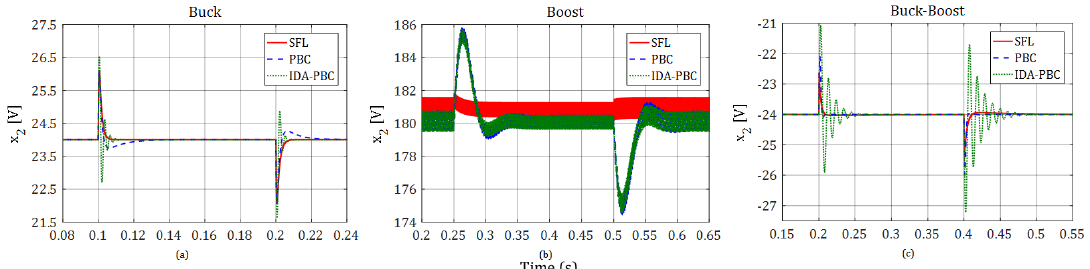
Figure 19. Software simulation result using control techniques SFL (red), PBC (blue) and IDA-PBC (green). Output voltage x 2 for buck ( a ) and boost PFC ( b ); buck-boost ( c ) for load variation in 0.25 s and 0.75 s.